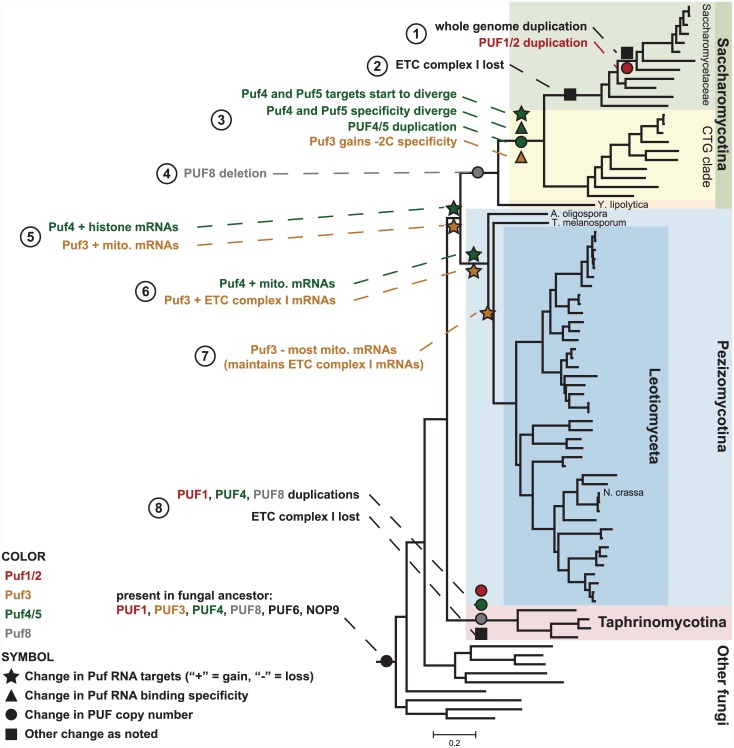
Phylogenetic model for changes in Puf proteins and their RNA interactions throughout fungal evolution.Symbols indicate the type of change, and colors link the indicated event to a particular Puf protein.